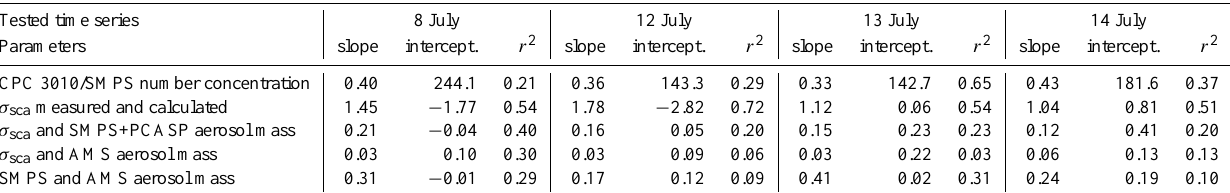
Table 1. Slope, interception and correlation coefficient determined from linear regression for flights used for this study between different measurement parameters (as presented in Fig.